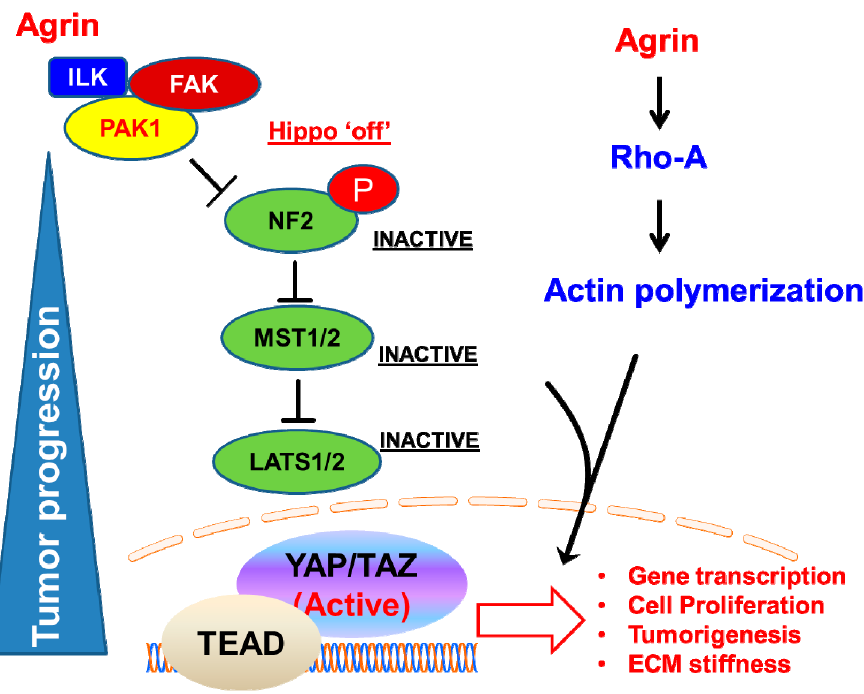
Figure 4. Agrin stimulates integrin-FAK-ILK-PAK1 mechanosignalling pathway to antagonize the Hippo pathway and activate YAP/TAZ mediated gene transcription.